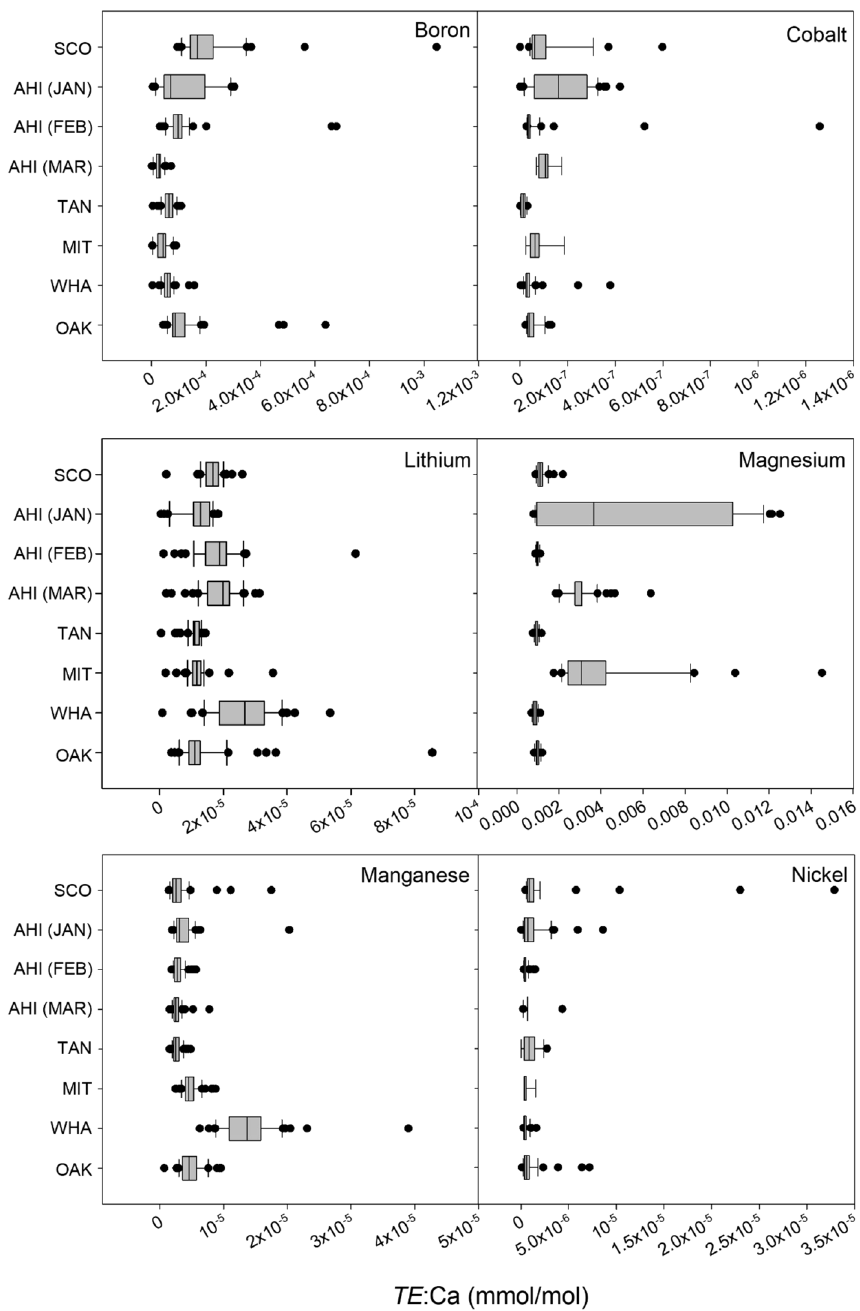
Figure 3. Boxplots of elemental ratios ( TE :Ca on x-axis) quantified via ICP-MS in shells of juvenile green- lipped mussels ( P. canaliculus ) collected from Scott Point (SCO), Ahipara (AHI, Jan, Feb, Mar), Tanutanu Beach (TAN), Mitimiti (MIT), Whatipu (WHA) and Oakura (OAK) in 2015. Sites are displayed from north to south on the y-axis. Solid lines within the box indicate medians, boxes and whiskers indicate the 10th, 25th, 75th and 90th percentiles,